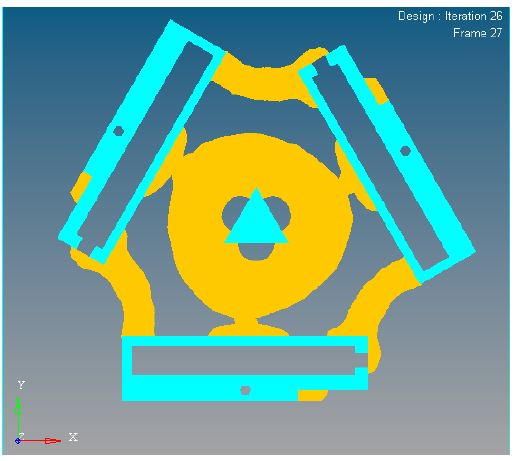
Figure 11. The material element distribution of dynamics topological optimization results.